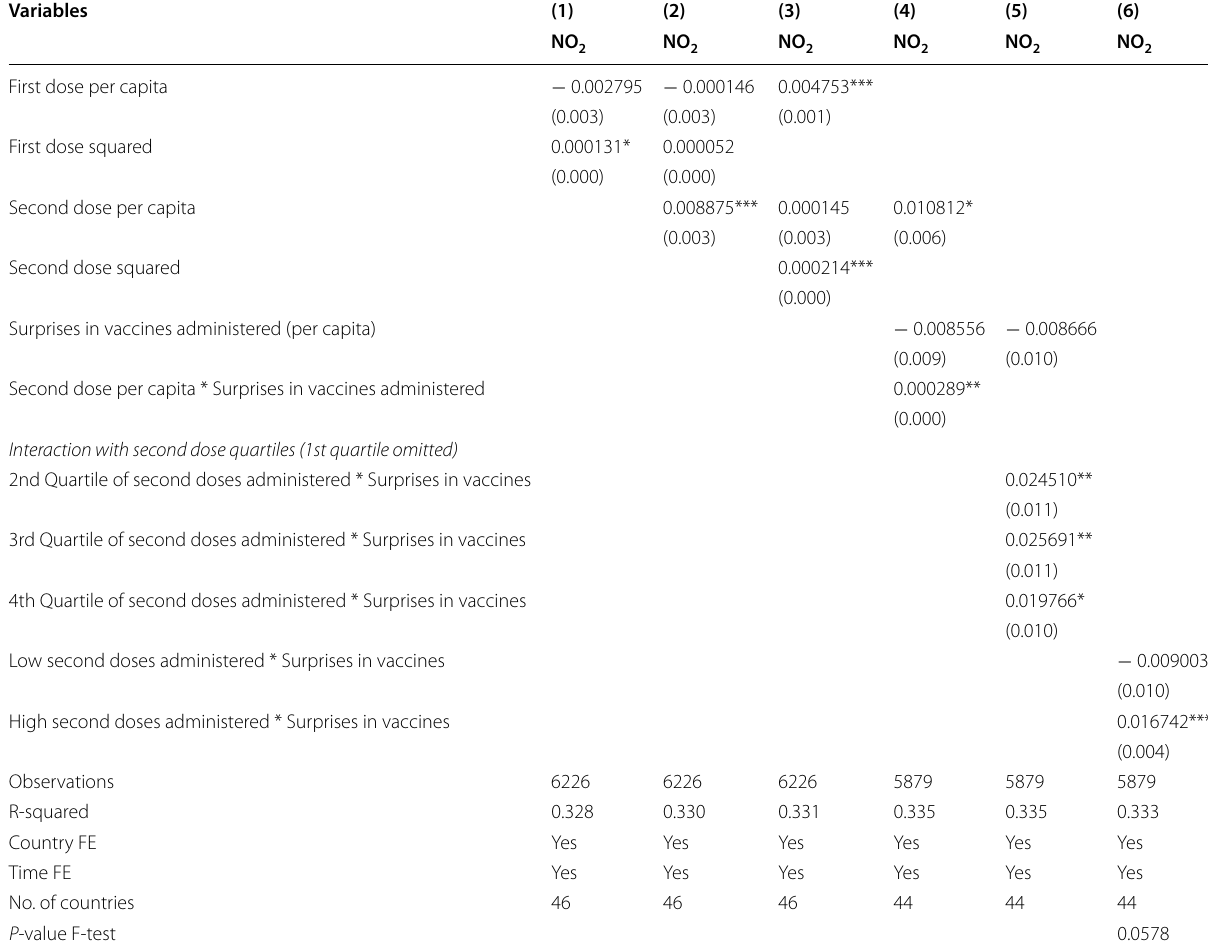
Table 4 Nonlinear effects of vaccines on economic